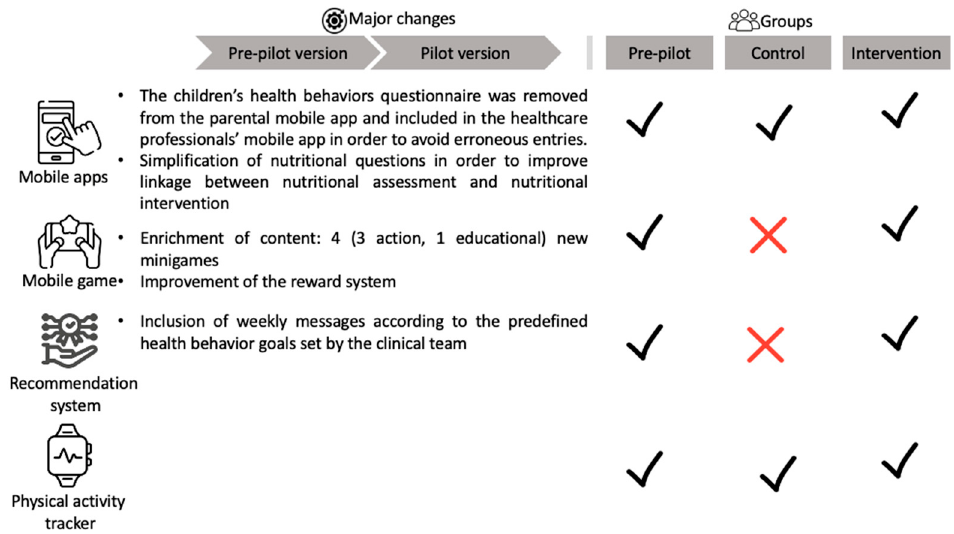
Figure 1. Major changes between pre-pilot and pilot intervention. The ENDORSE modules were utilized by each group for 12 weeks. Images: Flaticon.com (accessed on 10 February 2023).